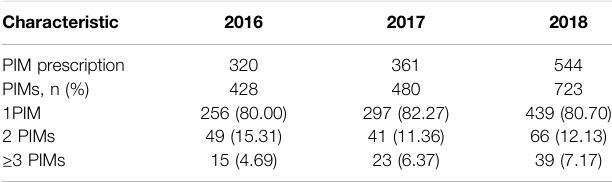
TABLE 2 | The number of PIMs used by older lung cancer outpatients.